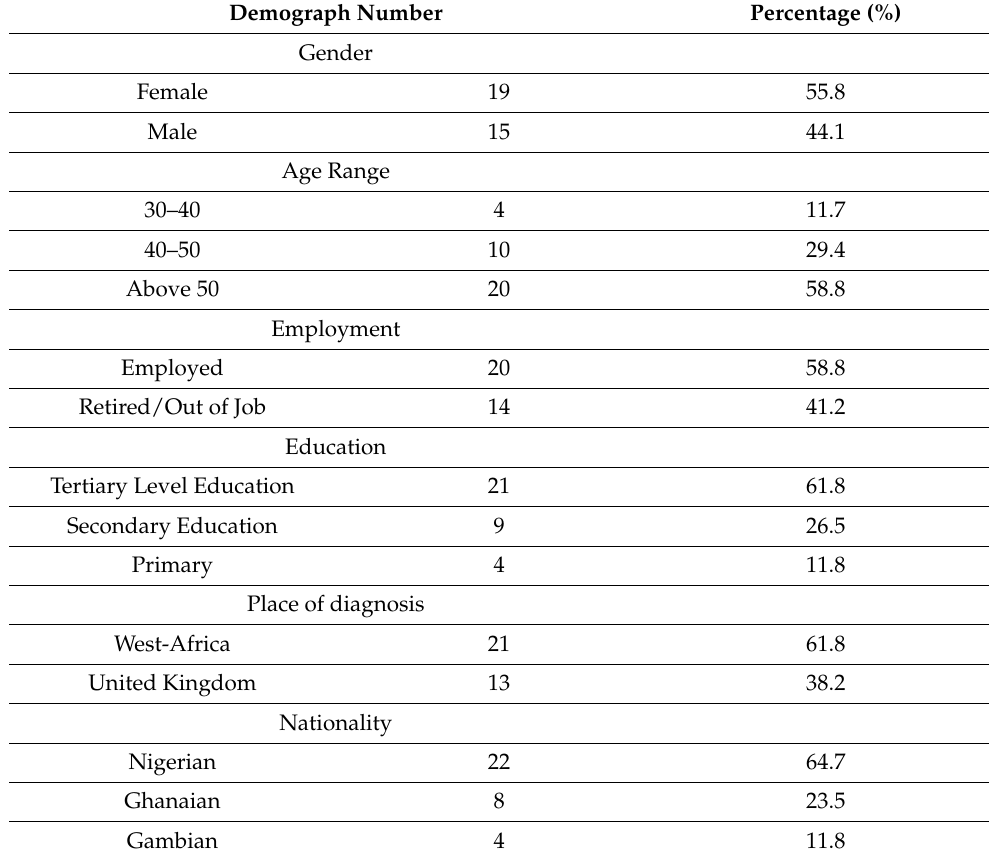
Table 1. Participants